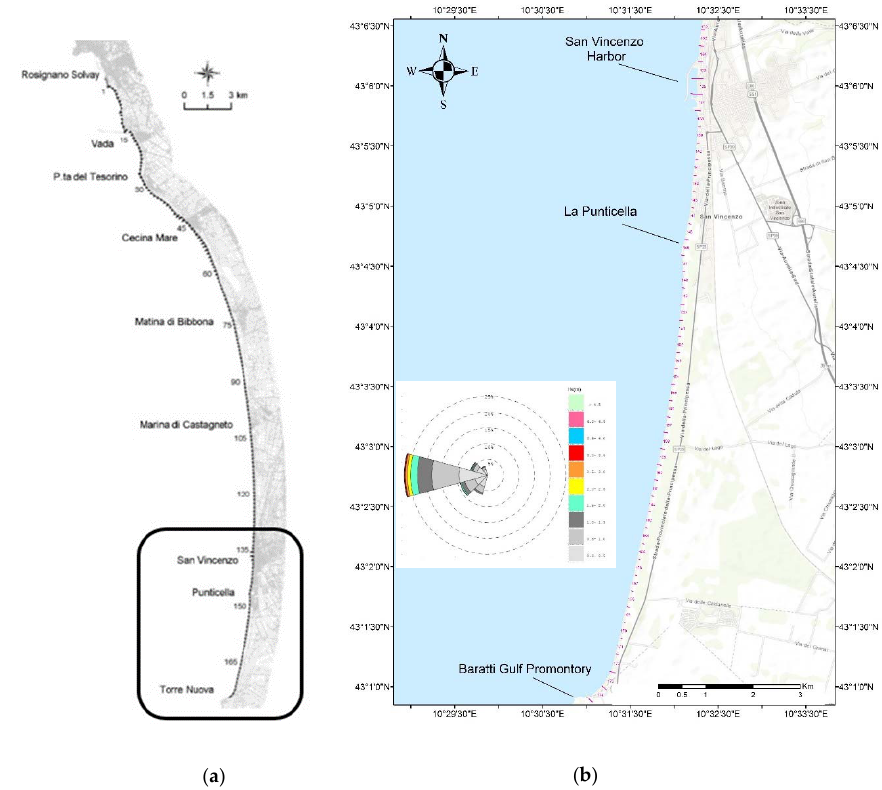
Figure 2. (a) Geographical framing, and sectorization of the Punta–Lillatro sediment cell [31]; (b) San Vincenzo’s littoral zone; in the small plot a rose diagram shows the wave’s field in front of San Vincenzo shore at a depth of 20 m [35,36].